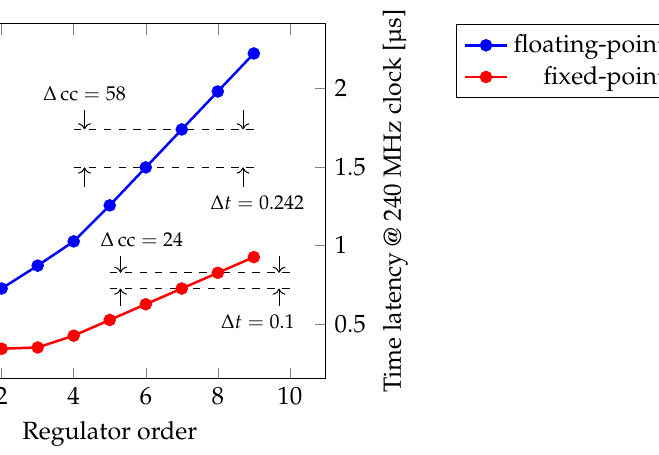
Figure 17. Time latency of the regulator busy state under various orders and data